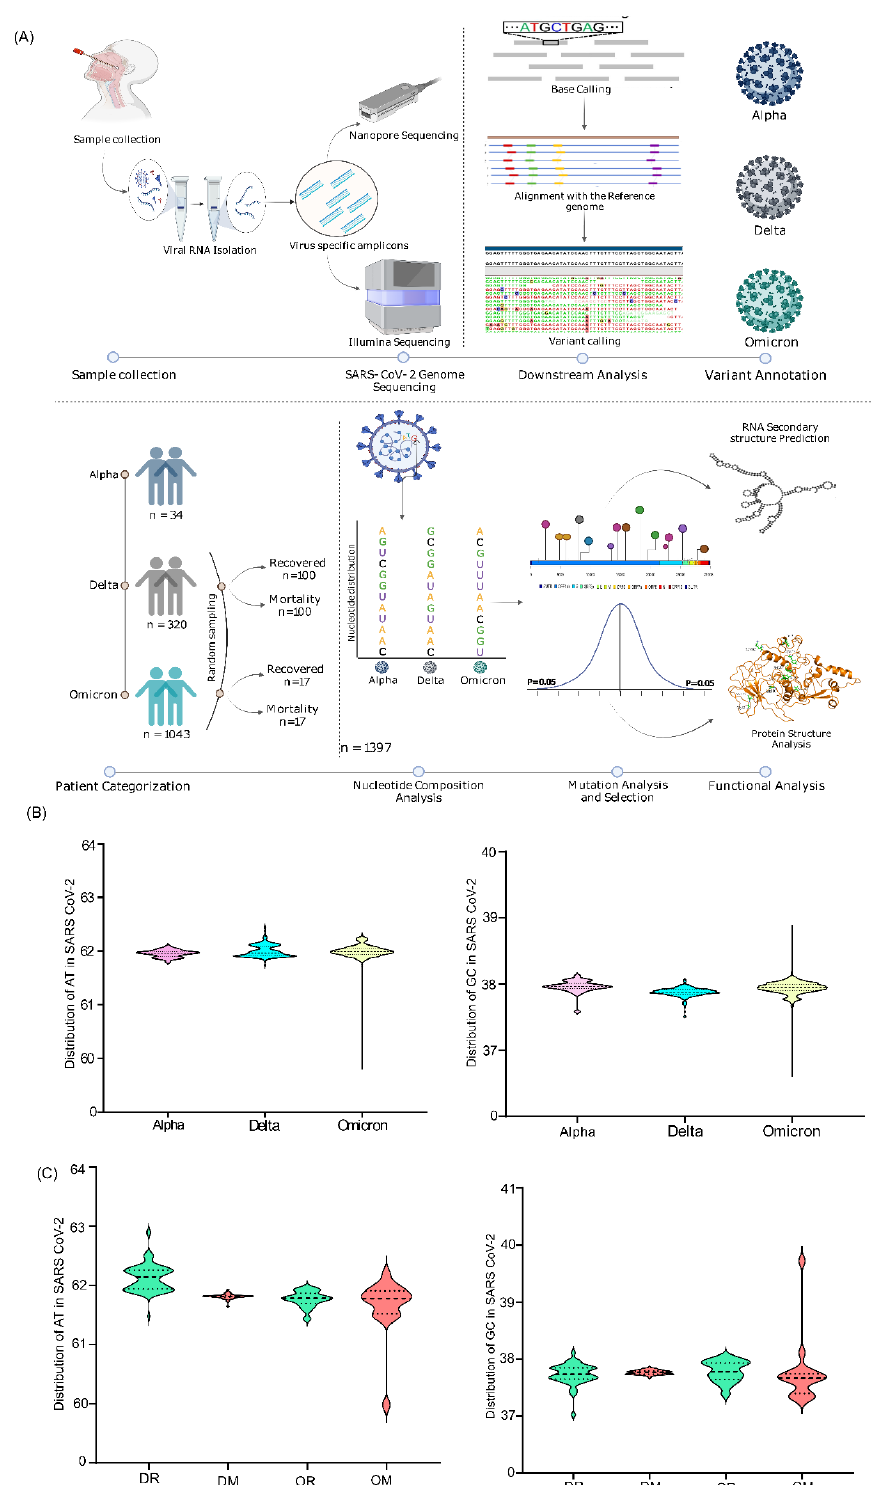
Figure 1. Study design and the Dinucleotide distribution across VOCs at the lineage and clinical outcome level. ( A ) the steps highlight the sample distribution across Alpha, Delta, and Omicron, sequencing data processing, and downstream analysis of the significant mutations. ( B ) AT/U and GC distribution in the genomes of the Alpha, Delta, and Omicron samples included in the study. ( C ) AT/U and GC distribution across the clinical outcomes with VOCs infection—DR, DM, OR, and